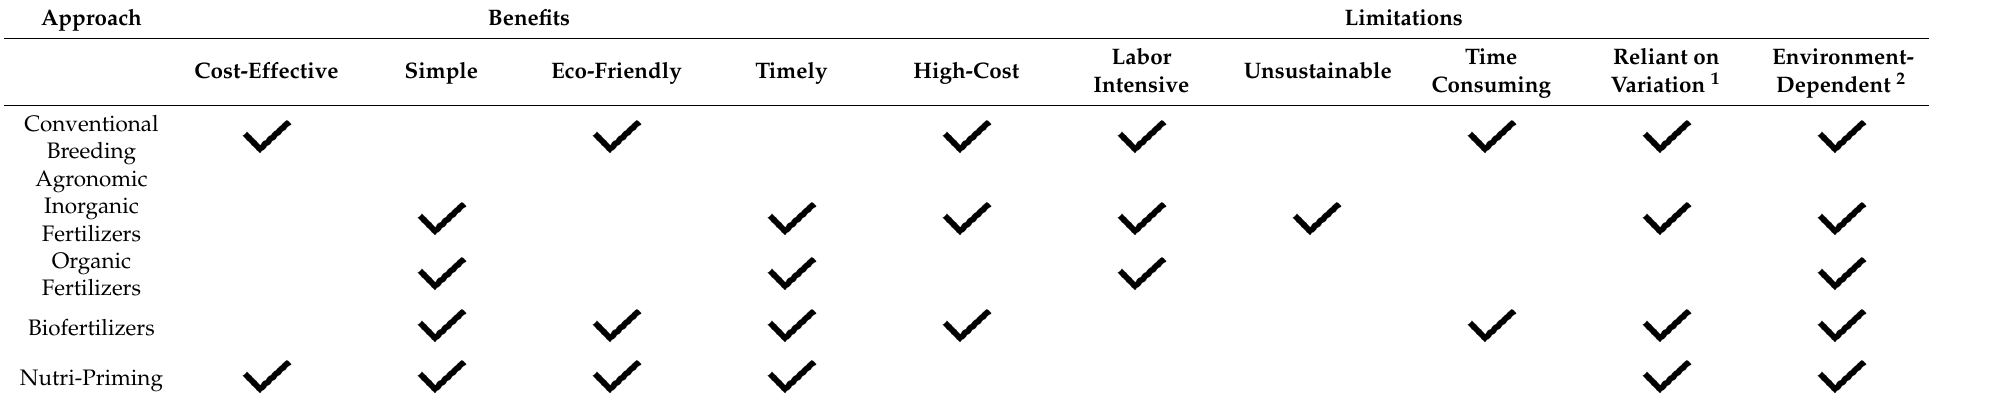
Table 1. Benefits and limitations of conventional breeding and agronomic biofortification approaches.